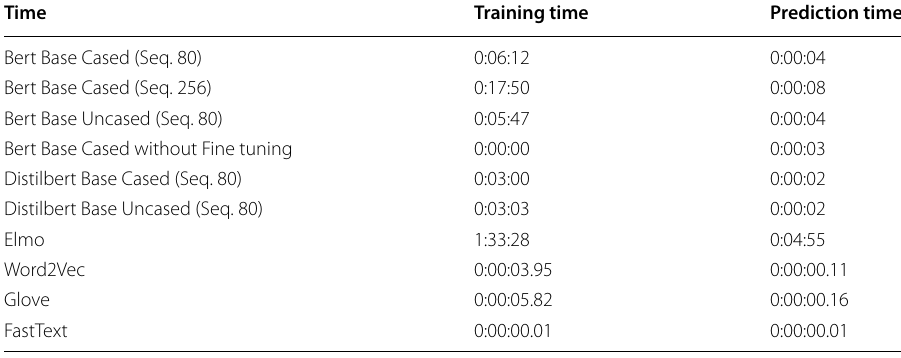
Table 3 Modelling time